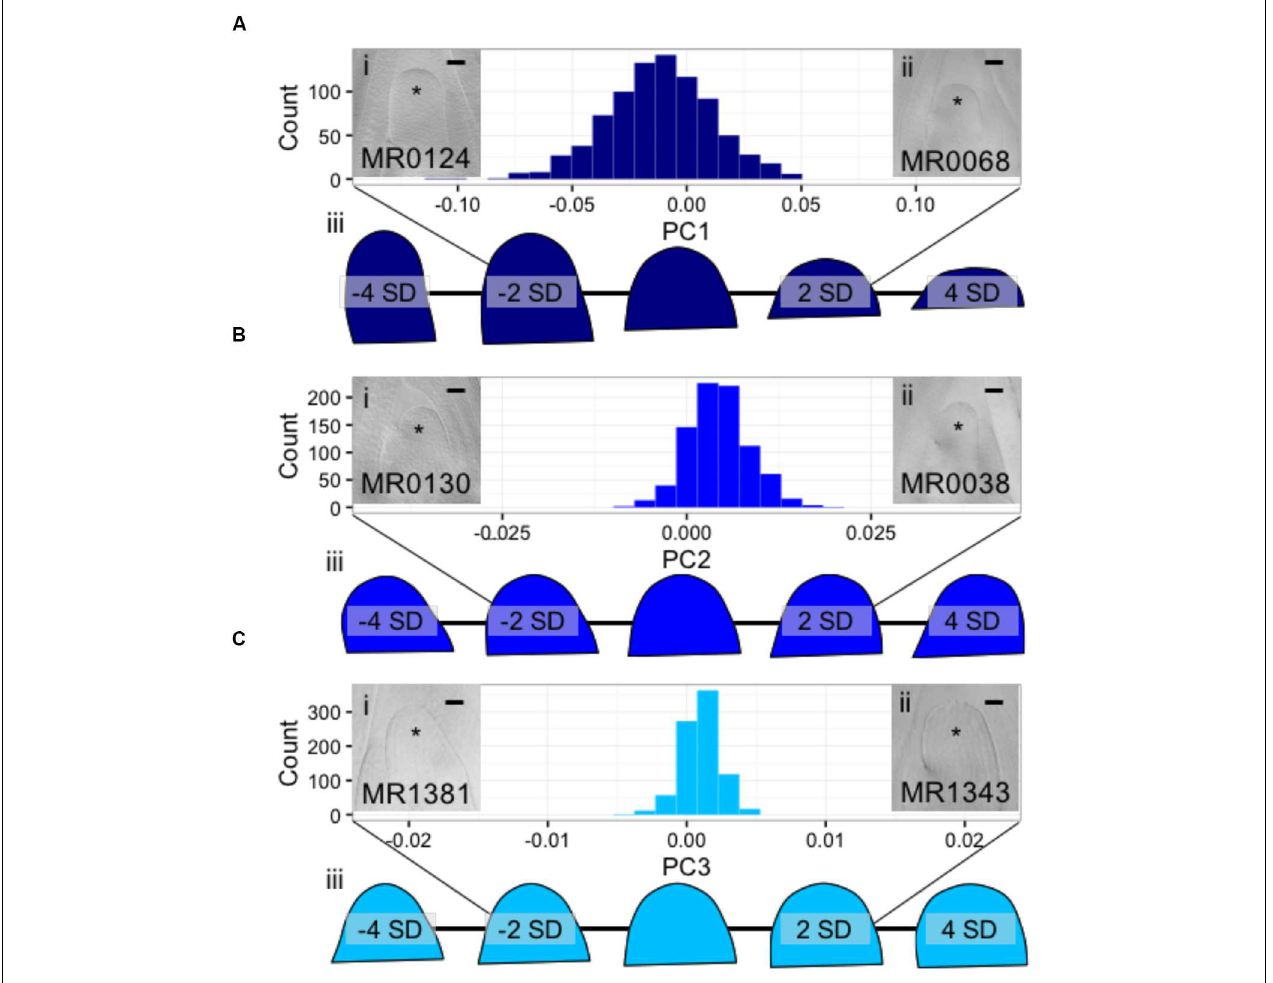
FIGURE 3 | Discreet cosine transformation identifies three SAM-morphology principal components (PCs) describing MxT meristem shape and size. (A) PC1 identifies SAMs that vary from highly elongated, post-like to flattened, dome-like. (B) PC2 identifies asymmetrical SAMs that vary from left-leaning to right-leaning within the plane of histological sectioning. (C) PC3 identifies SAMs that vary from highly peaked to rounded. /’ and /’/, median longitudinal images of meristems from MxT lines with low and high values for each PC, respectively. ∗ indicates SAM with flanking leaf primorida. //’/, renderings of expected SAM shapes with PC values of − 4, − 2, 0, 2, and 4 standard deviations from the average recorded SAM shape. Histogram x -axes, − 2 to 2 standard dev. Scale bars,